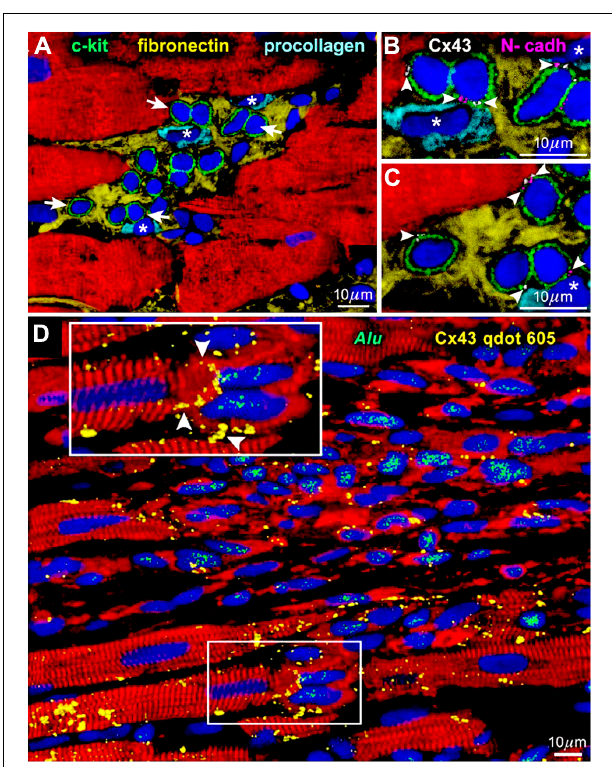
FIGURE 1 | Niches in the normal human heart (Bearzi etal., 2007). (A) c-kit-positive human cardiac stem cells (green) are clustered in interstitial spaces filled with fibronectin. Arrows in (A) define the areas in (B,C) . (B,C) At a higher magnification, gap (connexin 43: Cx43, white) and adherens (N-cadherin: N-cadh, magenta) junctions are detected between stem cells (green) and supporting cell, i.e., myocytes (red) and fibroblasts (*). (D) Connexin 43 (Cx43, yellow) is present between regenerated human myocytes (red; Alu , green) and spared rat myocytes (red; Alu -negative). See inset for a higher magnification.